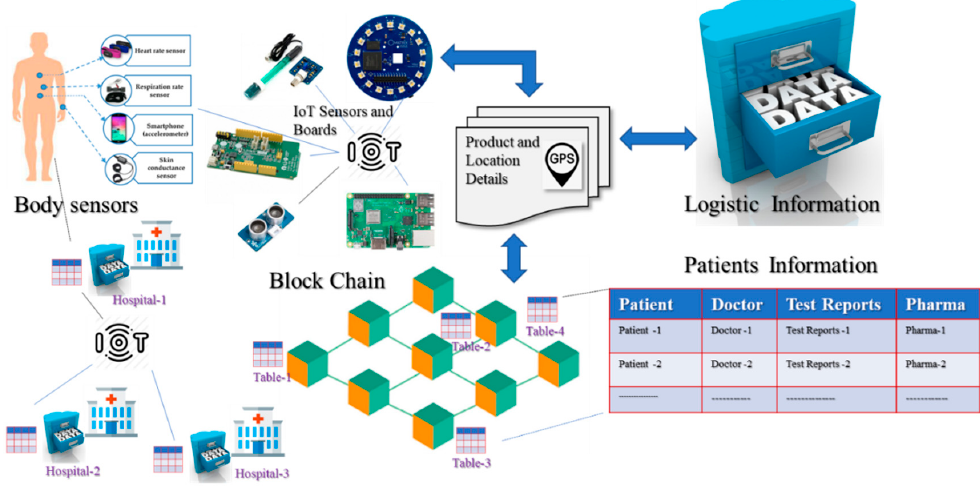
Figure 2. Blockchain architecture for Internet of Medical Things (IoMT) in e-healthcare.